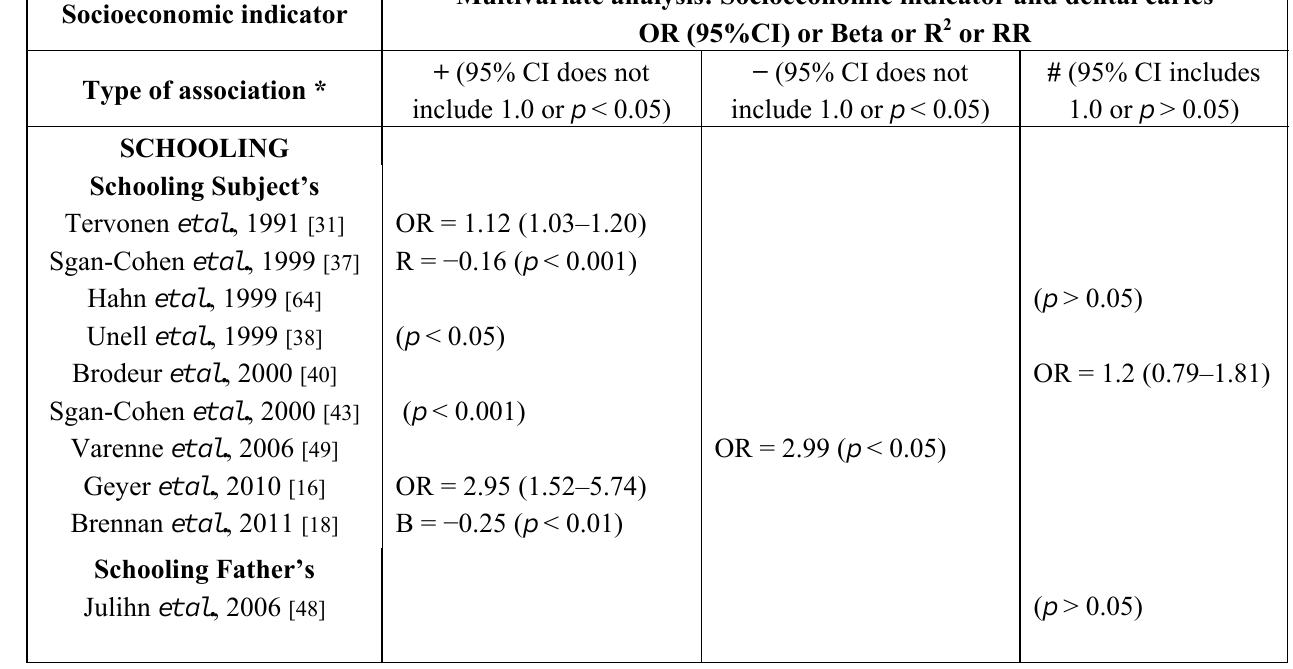
Table 4. Quantitative distribution of statistical analyses and type of association (positive (+), negative (–) or null (#)) according to socioeconomic